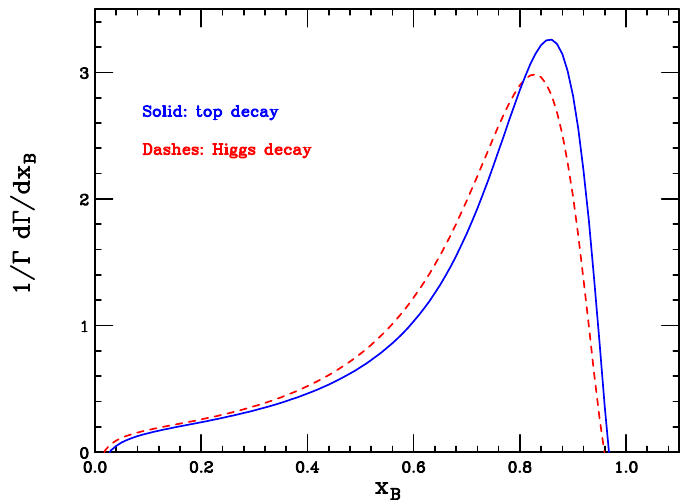
Figure 3. B -hadron spectrum in top (solid) and Higgs (dashes) decays, according to a NLO+NLL perturvative calculation and modelling non-perturbative corrections by means of the model (3), tuned to e + e − data.